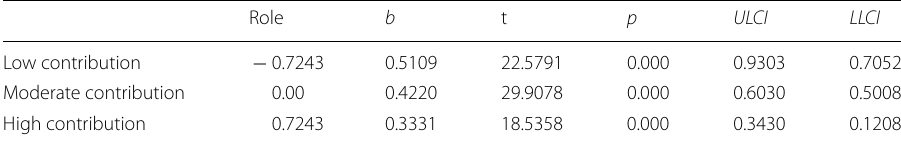
Table 2 Centered effects for amount of group work on germane load at each level of group role (contribution) (n =